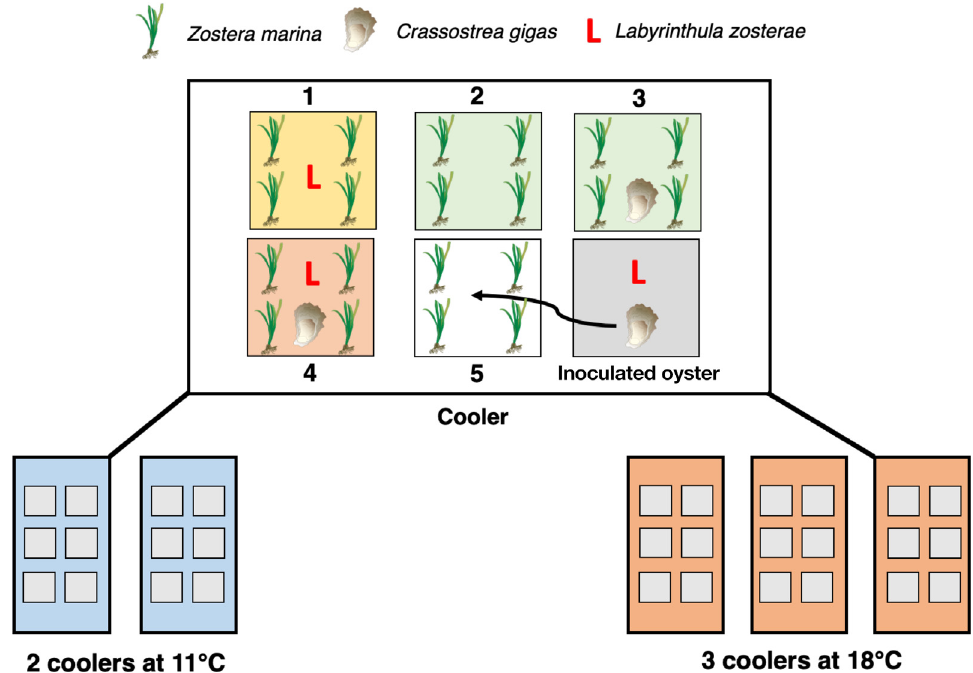
Fig. 1. The laboratory experiment set-up depicting treatments 1−5, with eelgrass Zostera marina either (1) inoculated with Labyrinthula zosterae (positive control), (2) alone (negative control; background infection assessment), (3) co-cultured with Pacific oysters Crassostrea gigas (negative control with oysters), (4) inoculated with L. zosterae and co-cultured with oysters (oyster and L. zosterae) , or (5) co-cultured with oysters exposed to L. zosterae added (inoculated oysters). Each tank (replicate) contained 4 eelgrass plants. The 5 treatments were replicated twice at 11°C and 3 times at 18°C. Temperature treatments were maintained by placing a full set of biological replicates (1−5) in a cooler held at the target